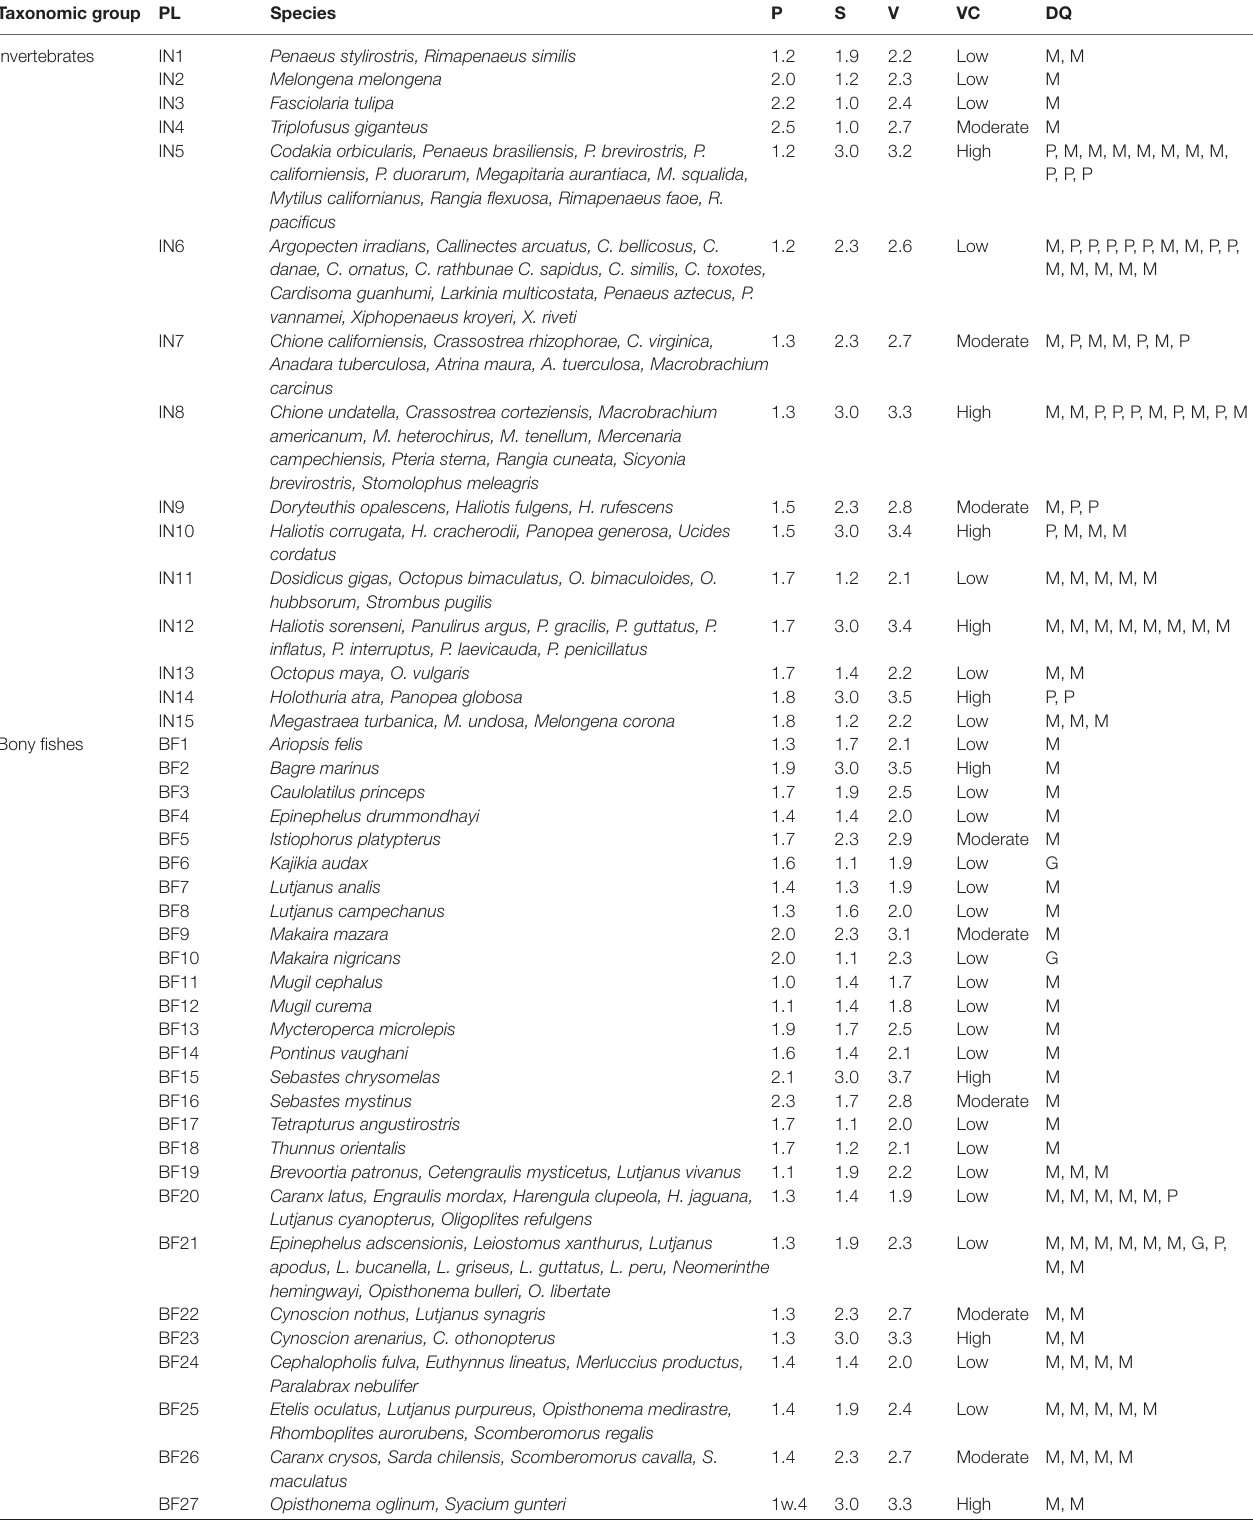
TABLE 3 | Overall scores and results of the productivity and susceptibility analysis (PSA) for species of high commercial importance species only (n = 208). Taxonomic group PL Species P S V VC